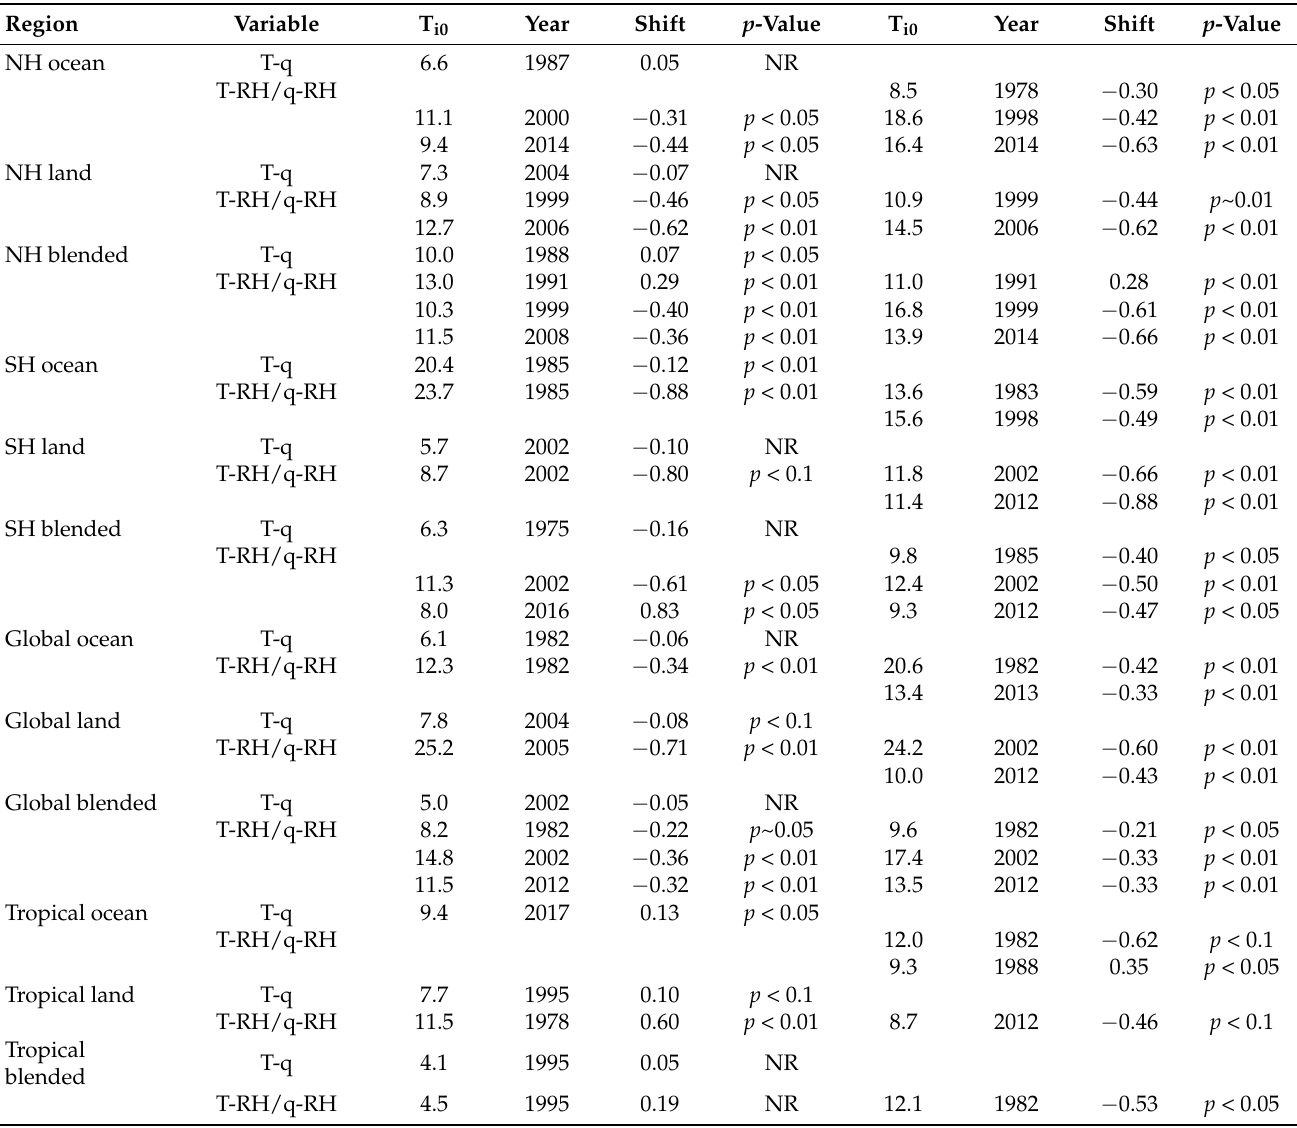
Table 5. Bivariate test result (T i0 ), year of shift, and p -value for regime changes in pairs with the reference first for temperature (T) specific humidity (q in g kg − 1 ) and relative humidity (RH in %) from HadISDH data. NR is no result, given for p > 0.1